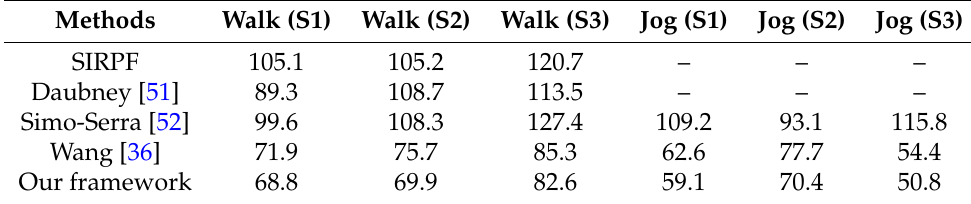
Table 2. The reconstruction of RMS errors on the HumanEva dataset for the two motion types with the other four three-dimensional methods. SIRPF, sequence importance resampling particle